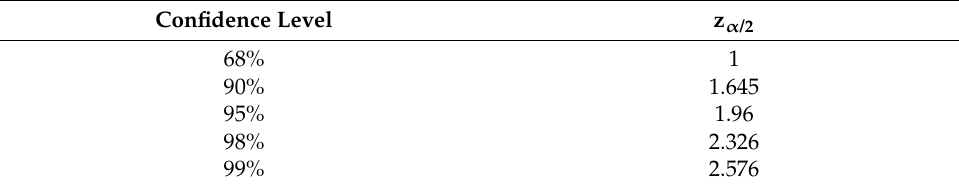
Table 1. z α /2 values for various confidence levels in normal